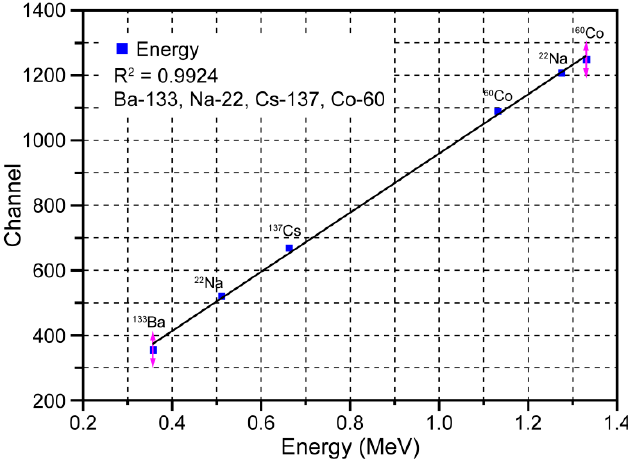
Figure 4. Linear fit of measured 133 Ba, 22 Na, 137 Cs, and 60 Co photopeak energies and channels.